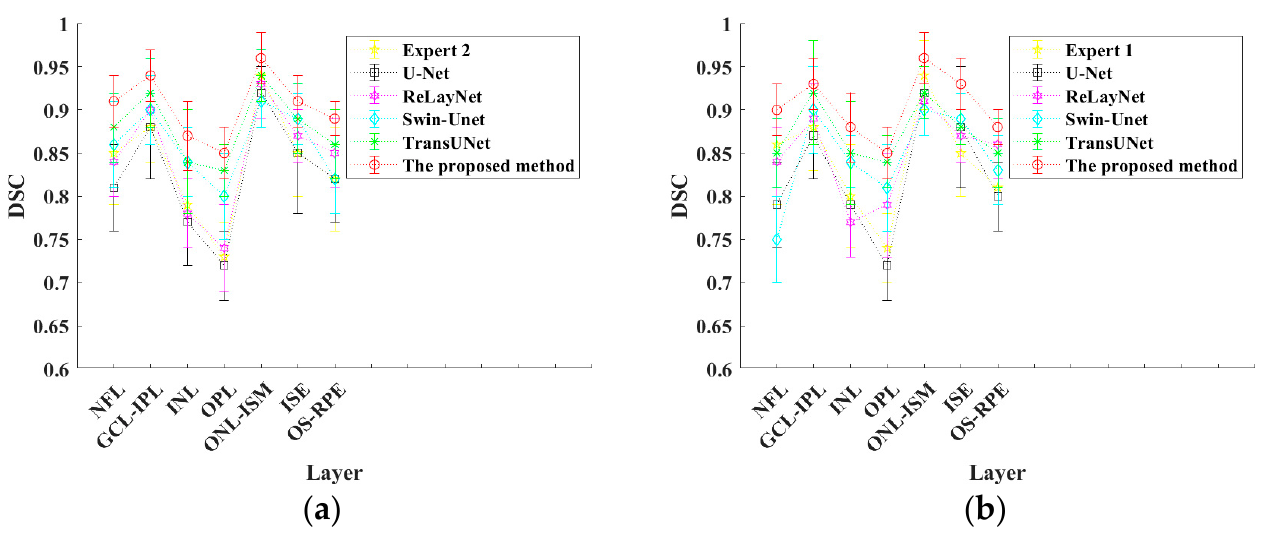
Figure 6. Error bar curves of different methods: ( a ) Expert 1 as the golden annotation; ( b ) Expert 2 as the golden annotation.